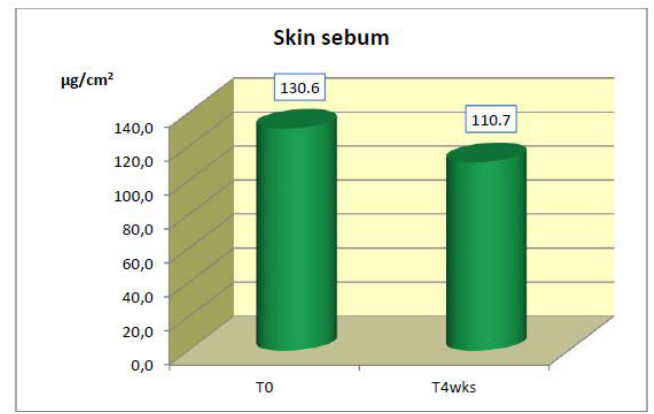
Figure 5. Skin sebum mean values.